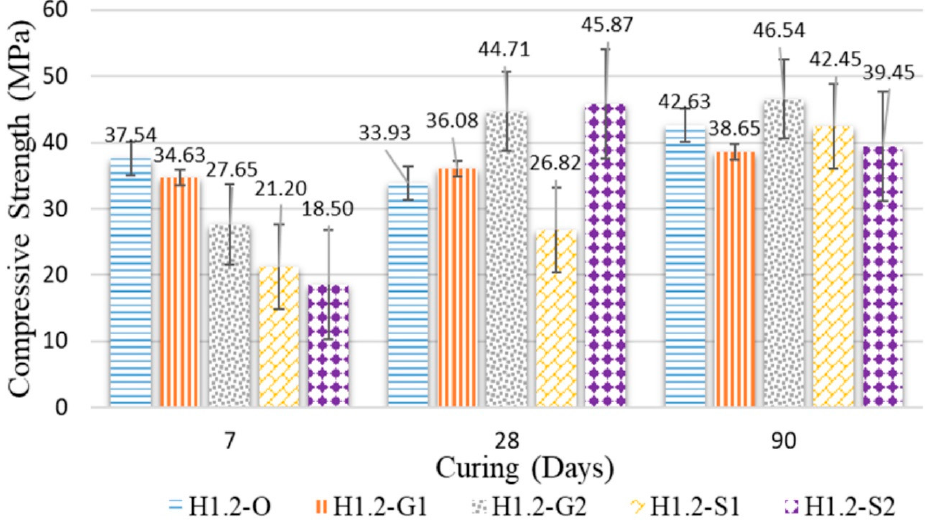
Figure 6. Compressive strength results for H1.2 high-strength pervious concrete specimens.